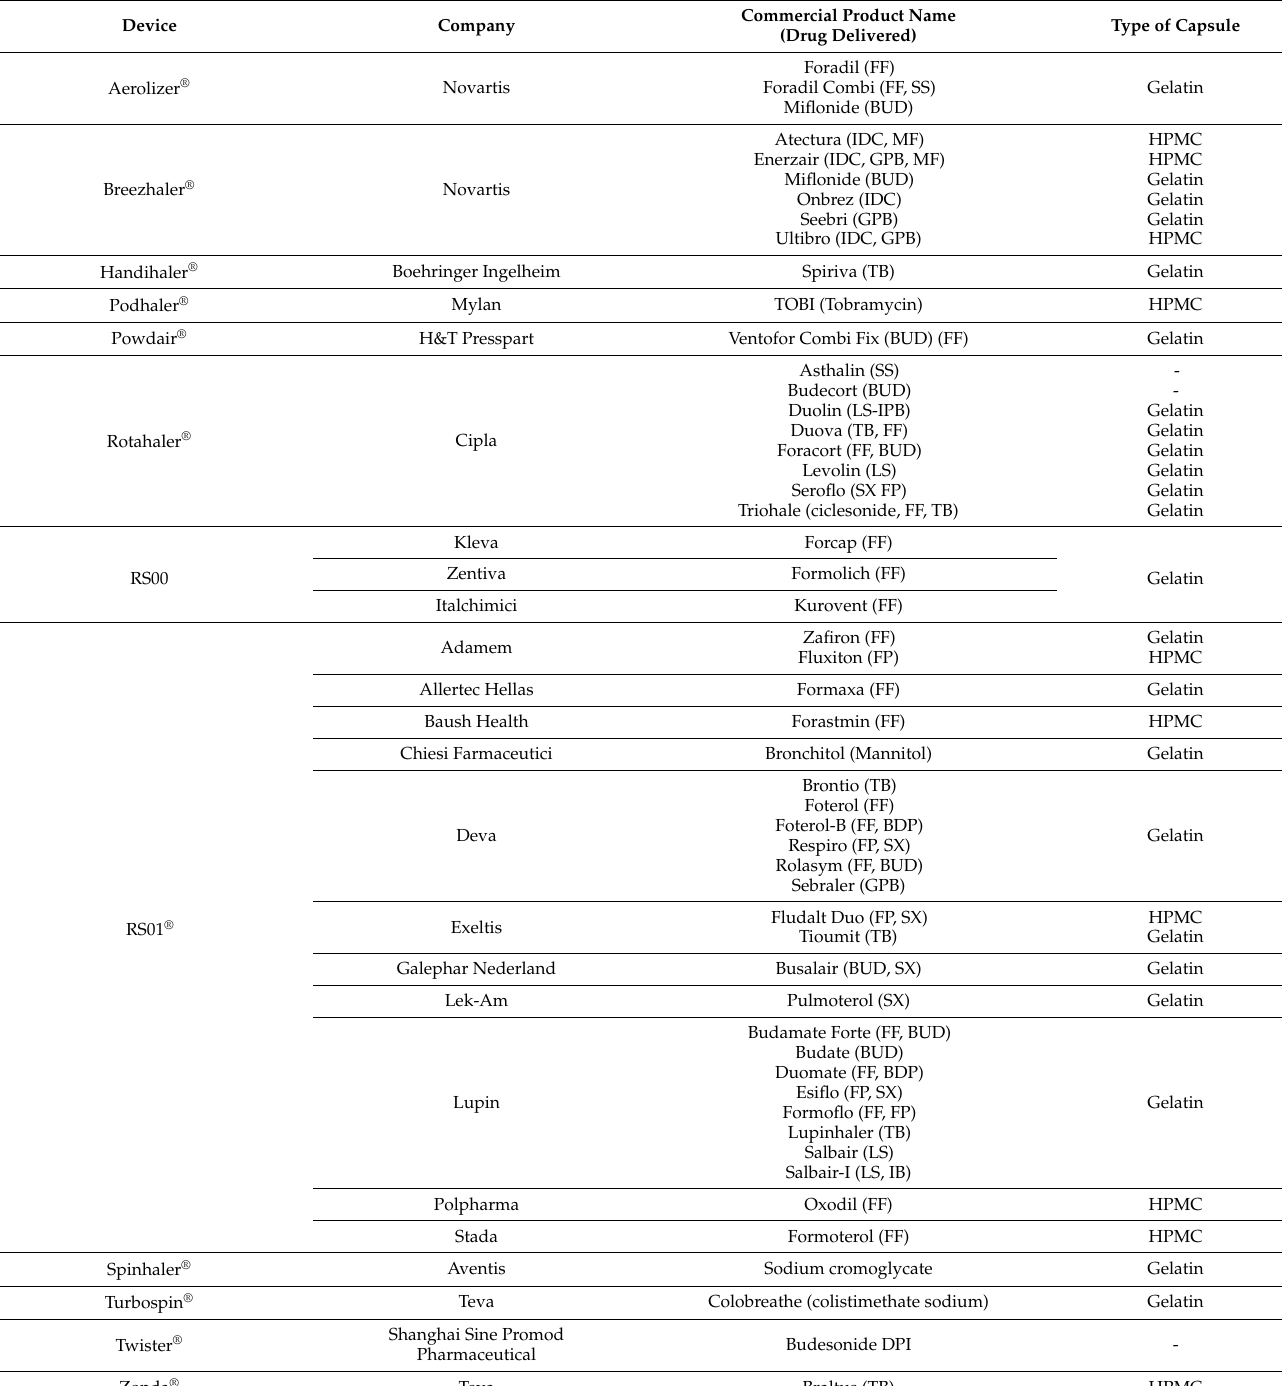
Table 1. Currently marketed single-dose capsule-based DPIs. The list is organized in alphabetical order according to the marketed device employed for product